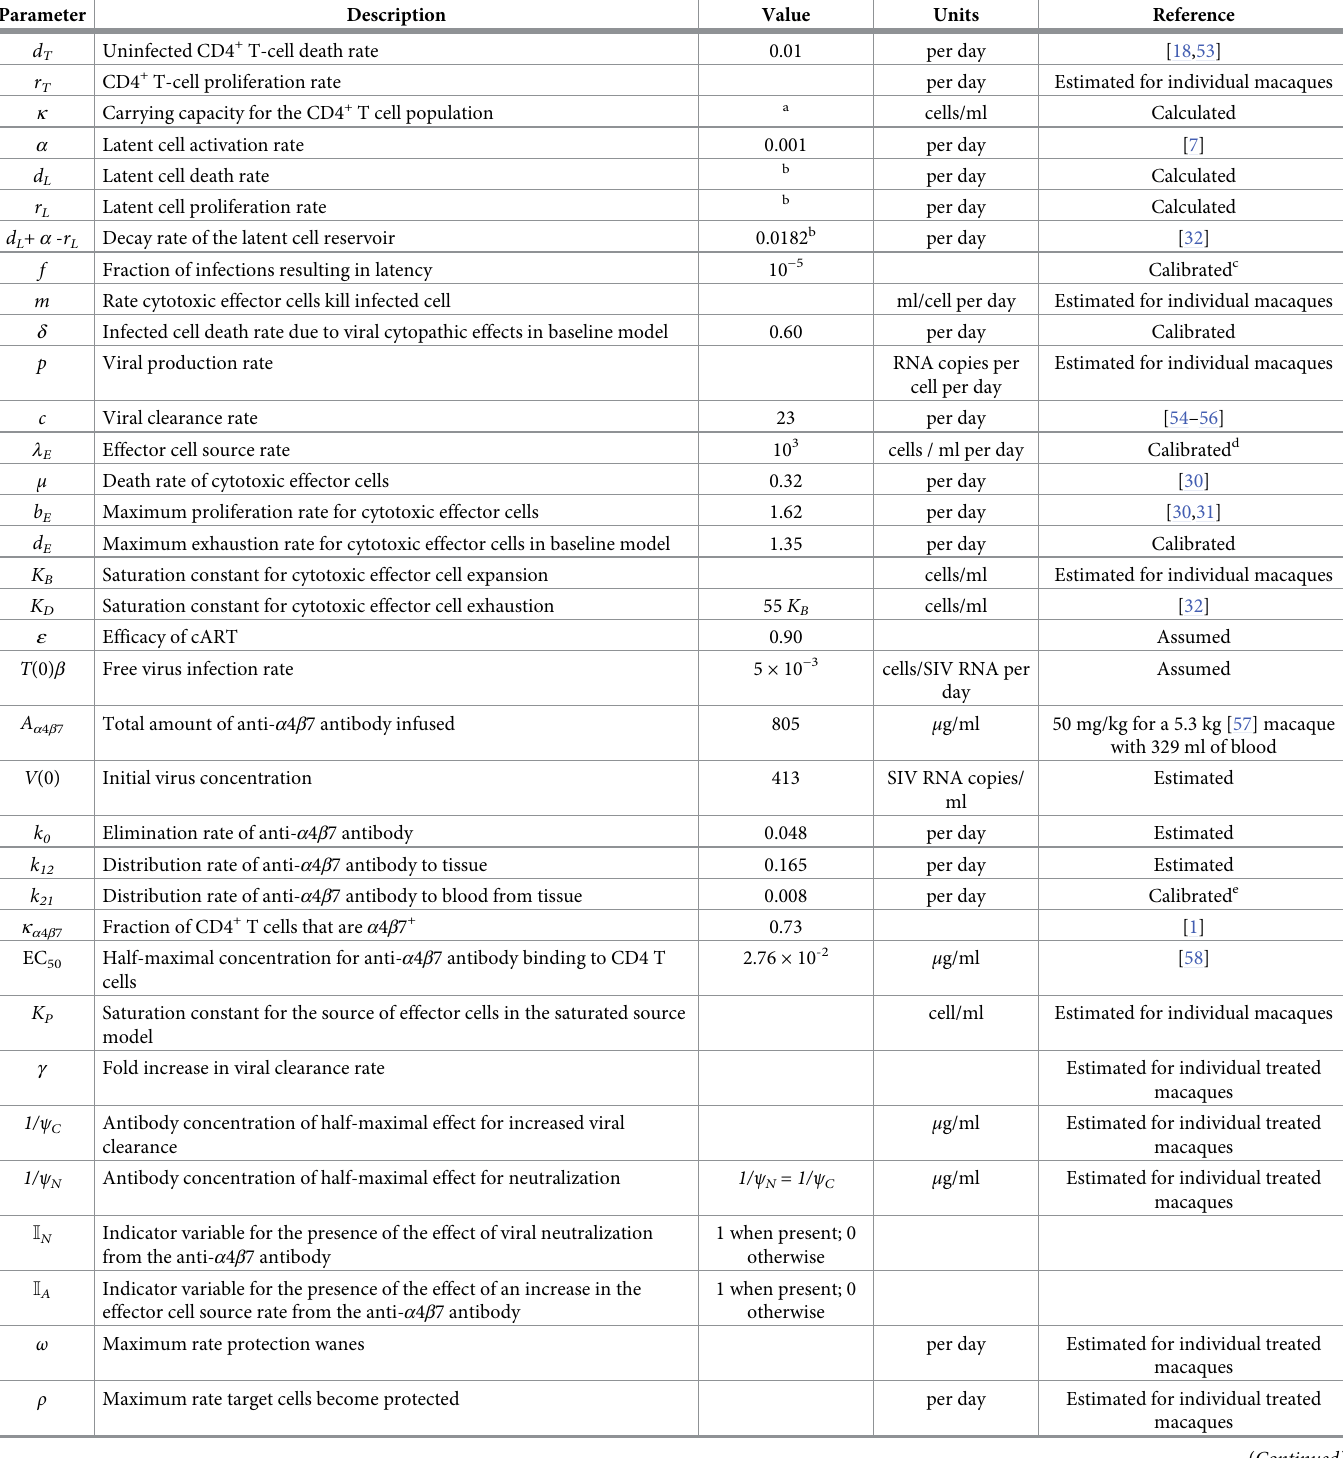
Table 1. Parameter definitions and